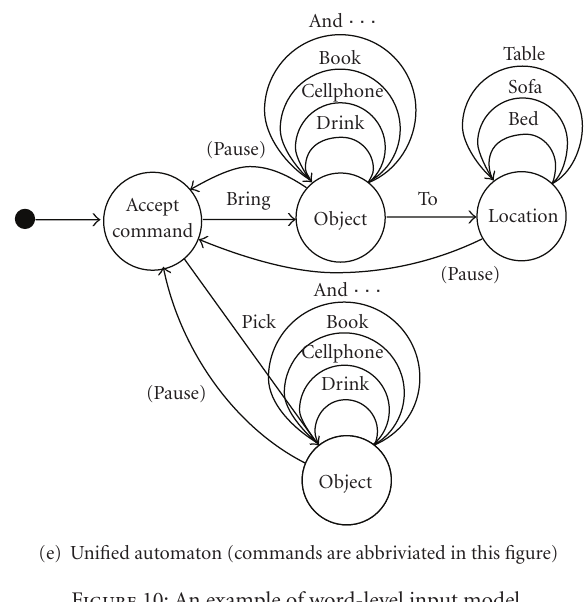
Figure 10: An example of word-level input